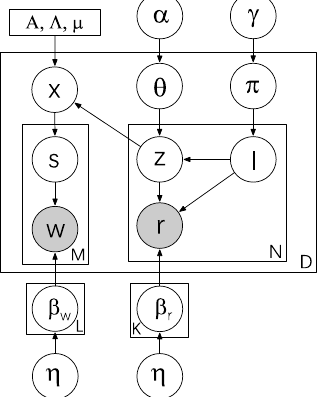
Figure 4. The diagram of proposed method.